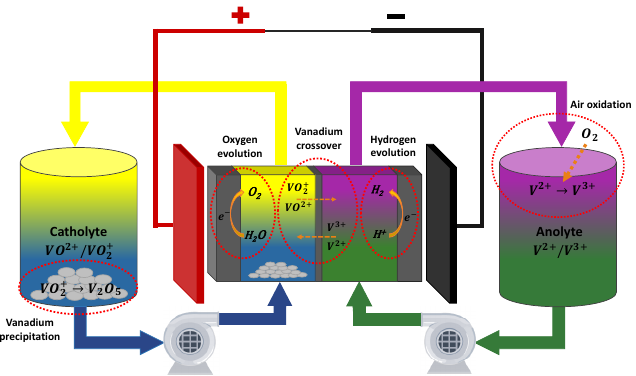
Figure 2. Scheme of a VRFB with its most important side